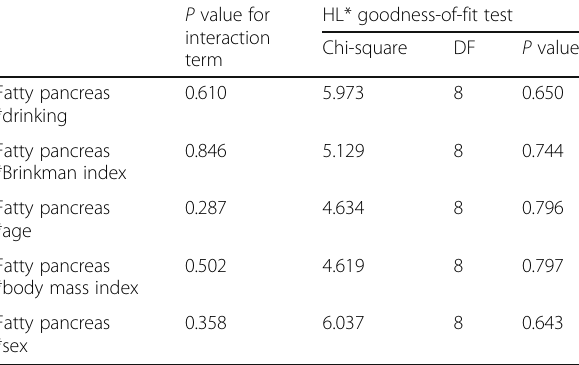
Table 3 Examination of the interactions in the multivariate logistic regression